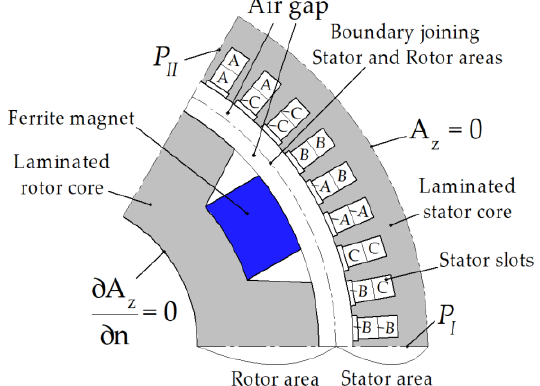
Figure 4. Computational domain.